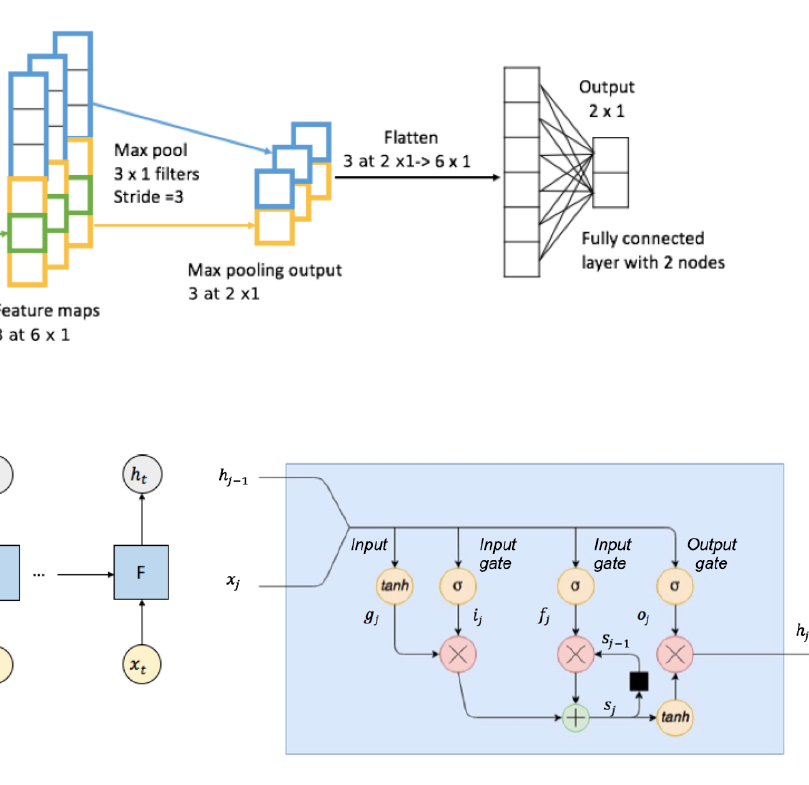
Figure 3. LSTM cell diagram (modified from Thomas,